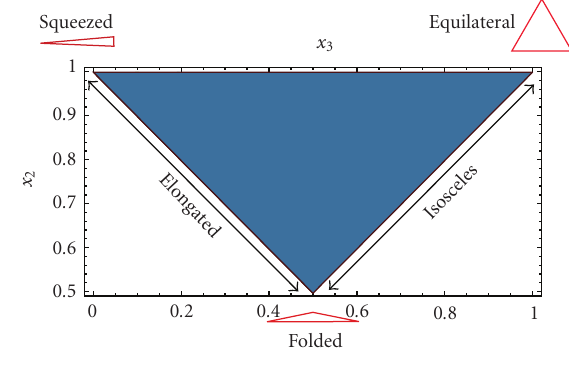
Figure 3: Shapes of non-Gaussianity. The shape function F ( k 1 , k 2 , k 3 ) forms a triangle in Fourier space. The triangles are parametrized by rescaled Fourier modes, x 2 = k 2 /k 1 and x 3 = k 3 /k 1 . Figure is from